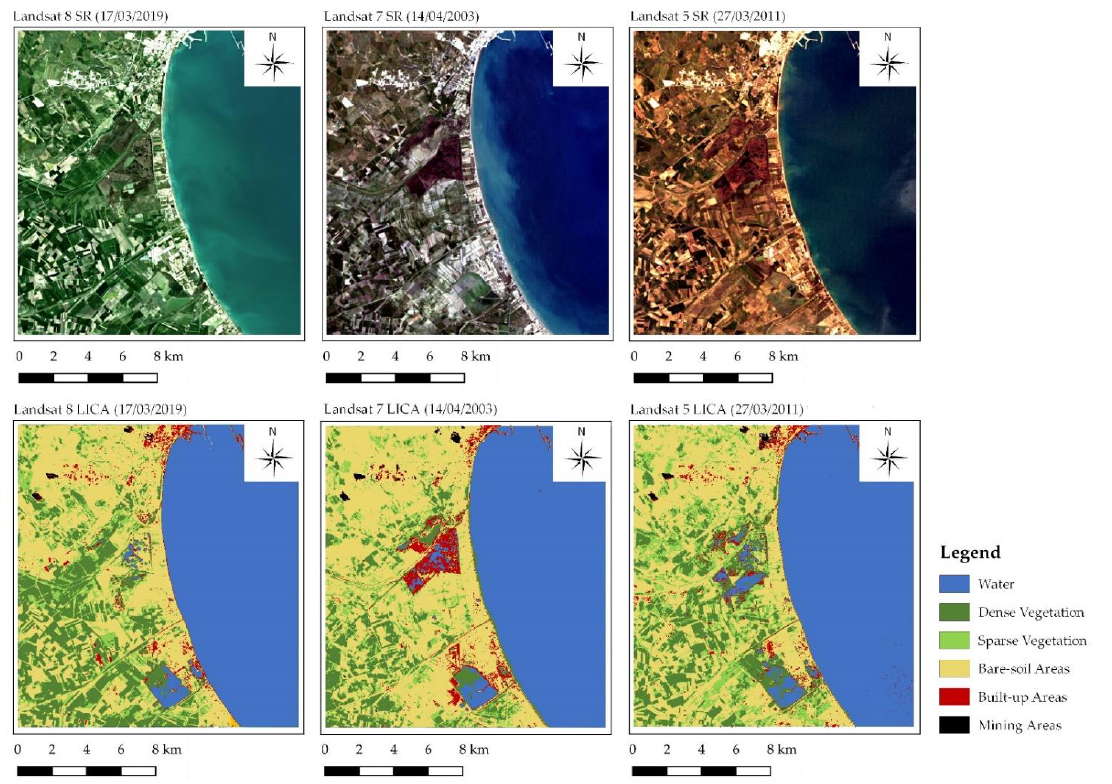
Figure 12. SwiRed index (SwiRed) classification outcome for Landsat 7 (image acquired on 14 April 2003). On the right, zoomed images with some misclassifications.